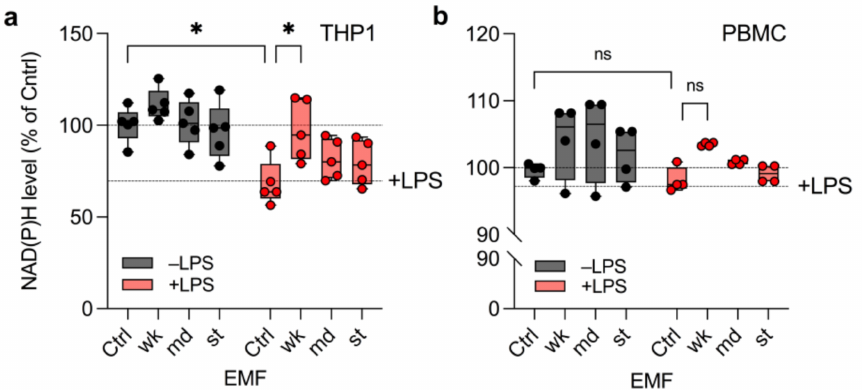
Figure 3. wkEMF counteracts NAD(P)H depletion in LPS-stimulated THP1. Both THP1 ( a ) and PBMC ( b ) were stimulated with or without LPS and exposed to wkEMF, mdEMF or stEMF for 1 h before measuring NAD(P)H levels by MTT assay to assess a potential interference of EMF with LPS-induced NAD(P)H depletion during ROS formation. Data was collected in n = 5 (THP1) or n = 4 (PBMC) individual experiments. ns: not significant, * p < 0.05 as